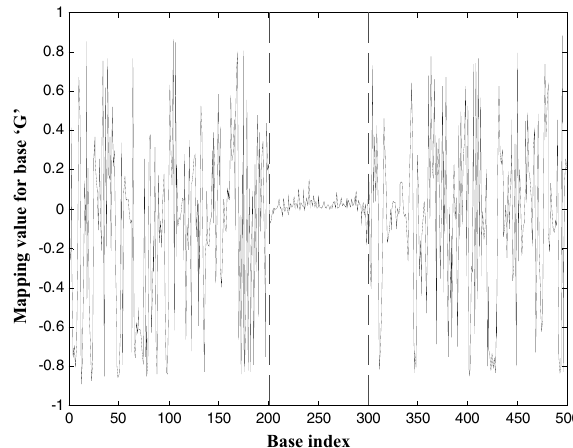
Figure 5 WT analysis of the synthetic DNA sequence based on fixed mapping.